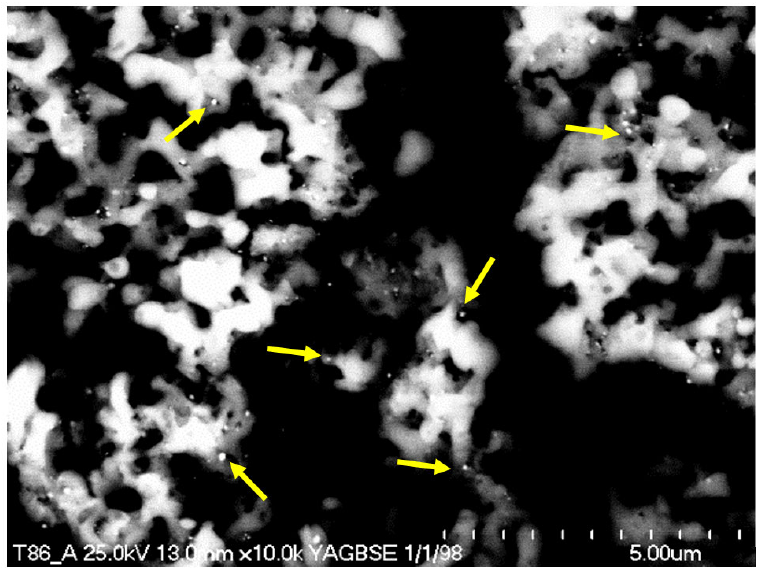
Figure 10. Backscattered electron–scanning electron microscope (BSE ‐ SEM) image of Pd/TiO 2 /Ti catalyst prepared with adsorption of Pd ions from a solution with 2% Pd ‐ wt. The yellow arrows indicate Pd particles on the surface.